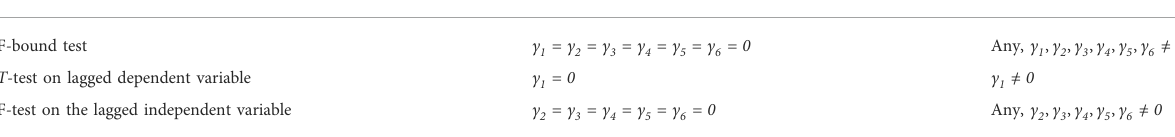
TABLE 2 Null hypotheses for all three tests are de fi ned as